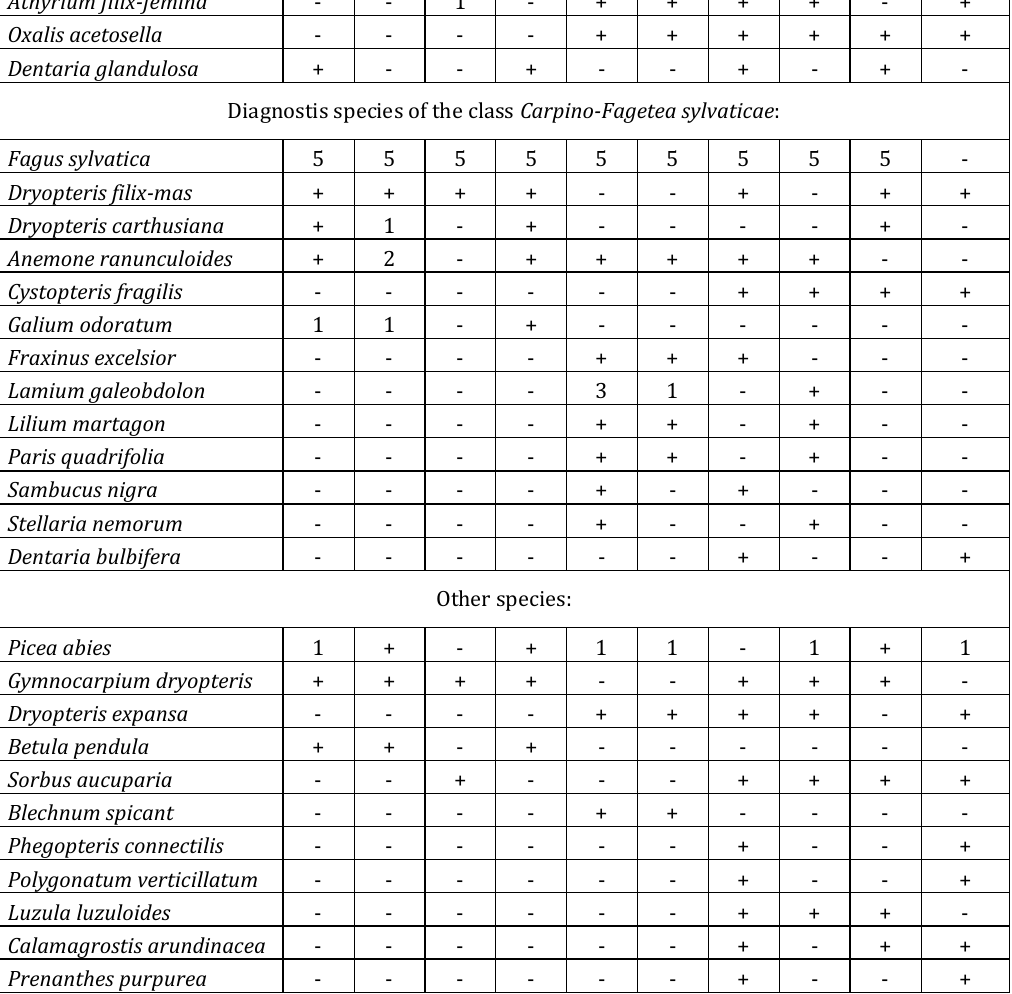
- - - - - - + - - + Species with low frequency: Circaea lutetiana (3:+), Corylus avellana (10:+), Dryopteris dilatata (7:+), Festuca altissima (9:+), Maianthemum bifolium (9:+), Mycelis muralis (8:+), Pinus sylvestris (7:+), Rubus idaeus (3:+), Stellaria holostea (6:+). Dates and locations of relevés: 1–4 – Kvasovetske ERD, compartment 14, 24 Jul 2012; 5–6 – Ostrytske ERD, compartment